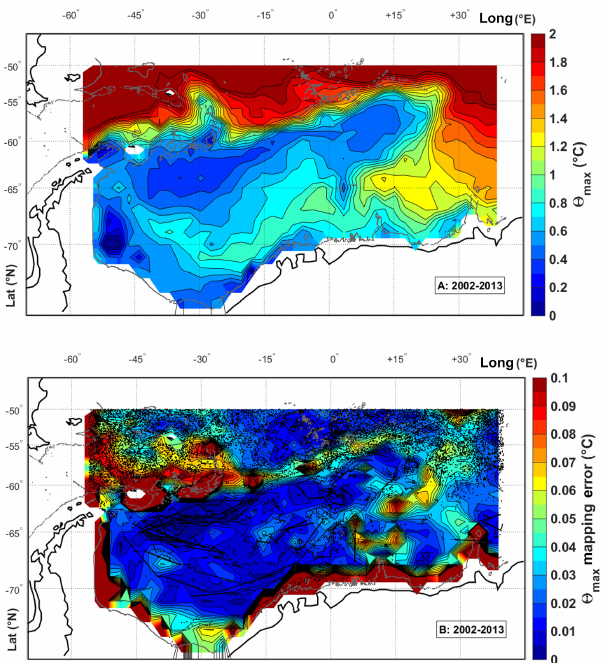
Figure 14. Conservative temperature ( ◦ C) at the sub-surface tem- perature maximum for the entire time period, where panel (a) shows the objectively mapped field based on the second approach (i.e. us- ing the mapped pressure of the sub-surface temperature maximum to extract the temperature data points). The mapping error is shown in panel (b) ; profile locations are marked as black dots. For more details, refer to Sect. 4.2. The grey contour shows the 2000m iso-